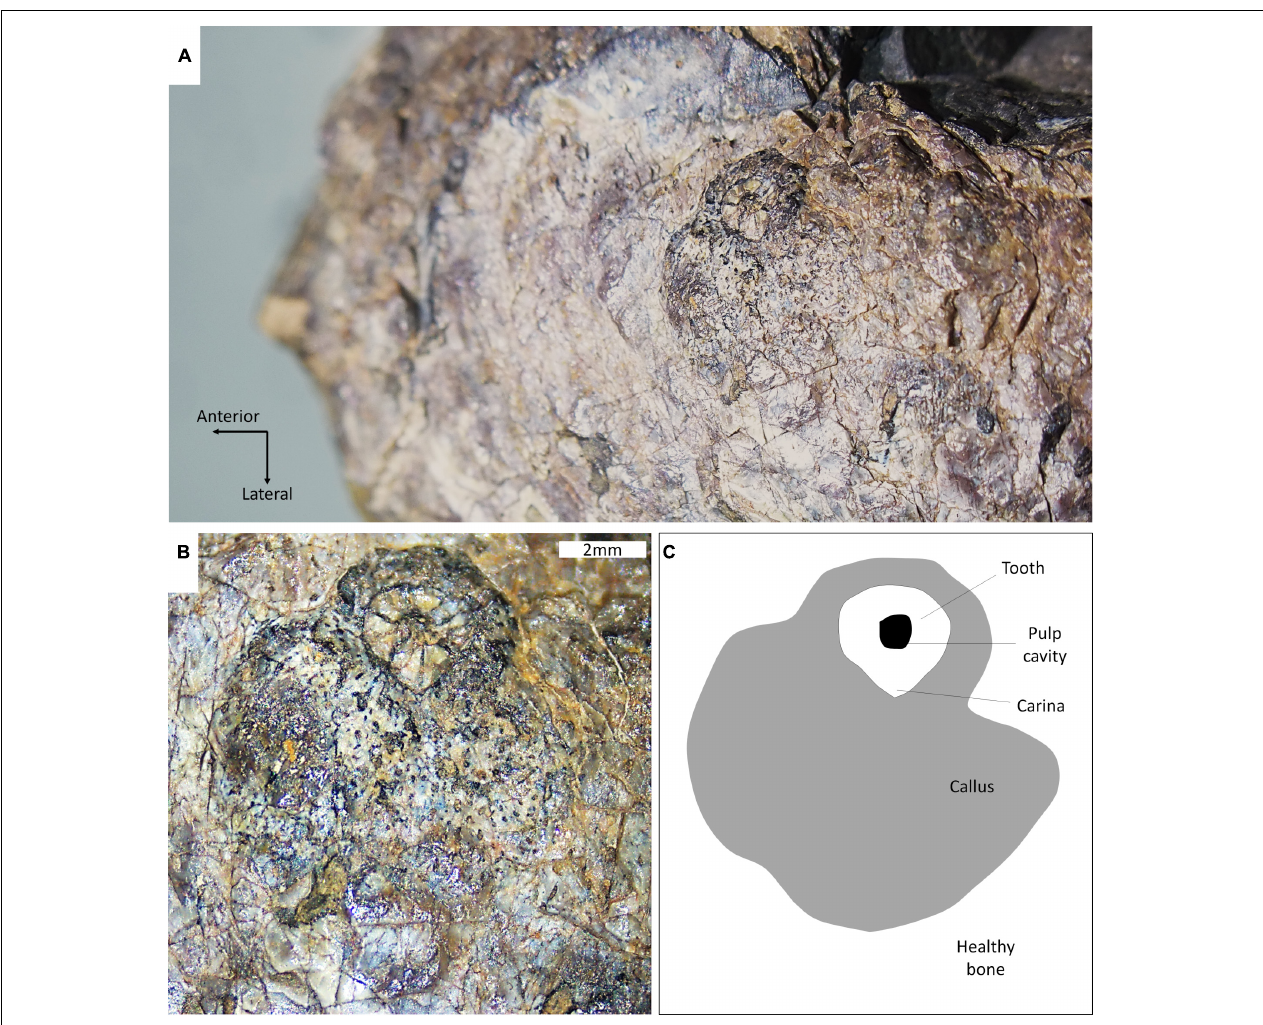
FIGURE 2 | Close-up views of the embedded tooth and callus of SAM-PK-11490. (A) Dorsolateral view of the tooth and callus; (B) lateral view of the tooth and callus; and (C) interpretive drawing of (B) .